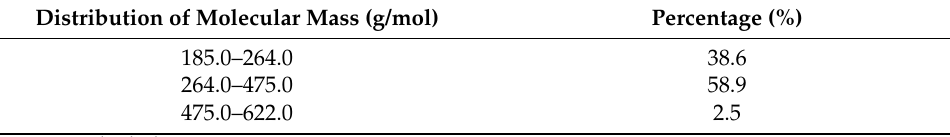
Table 2. The molecular mass distribution of PH.